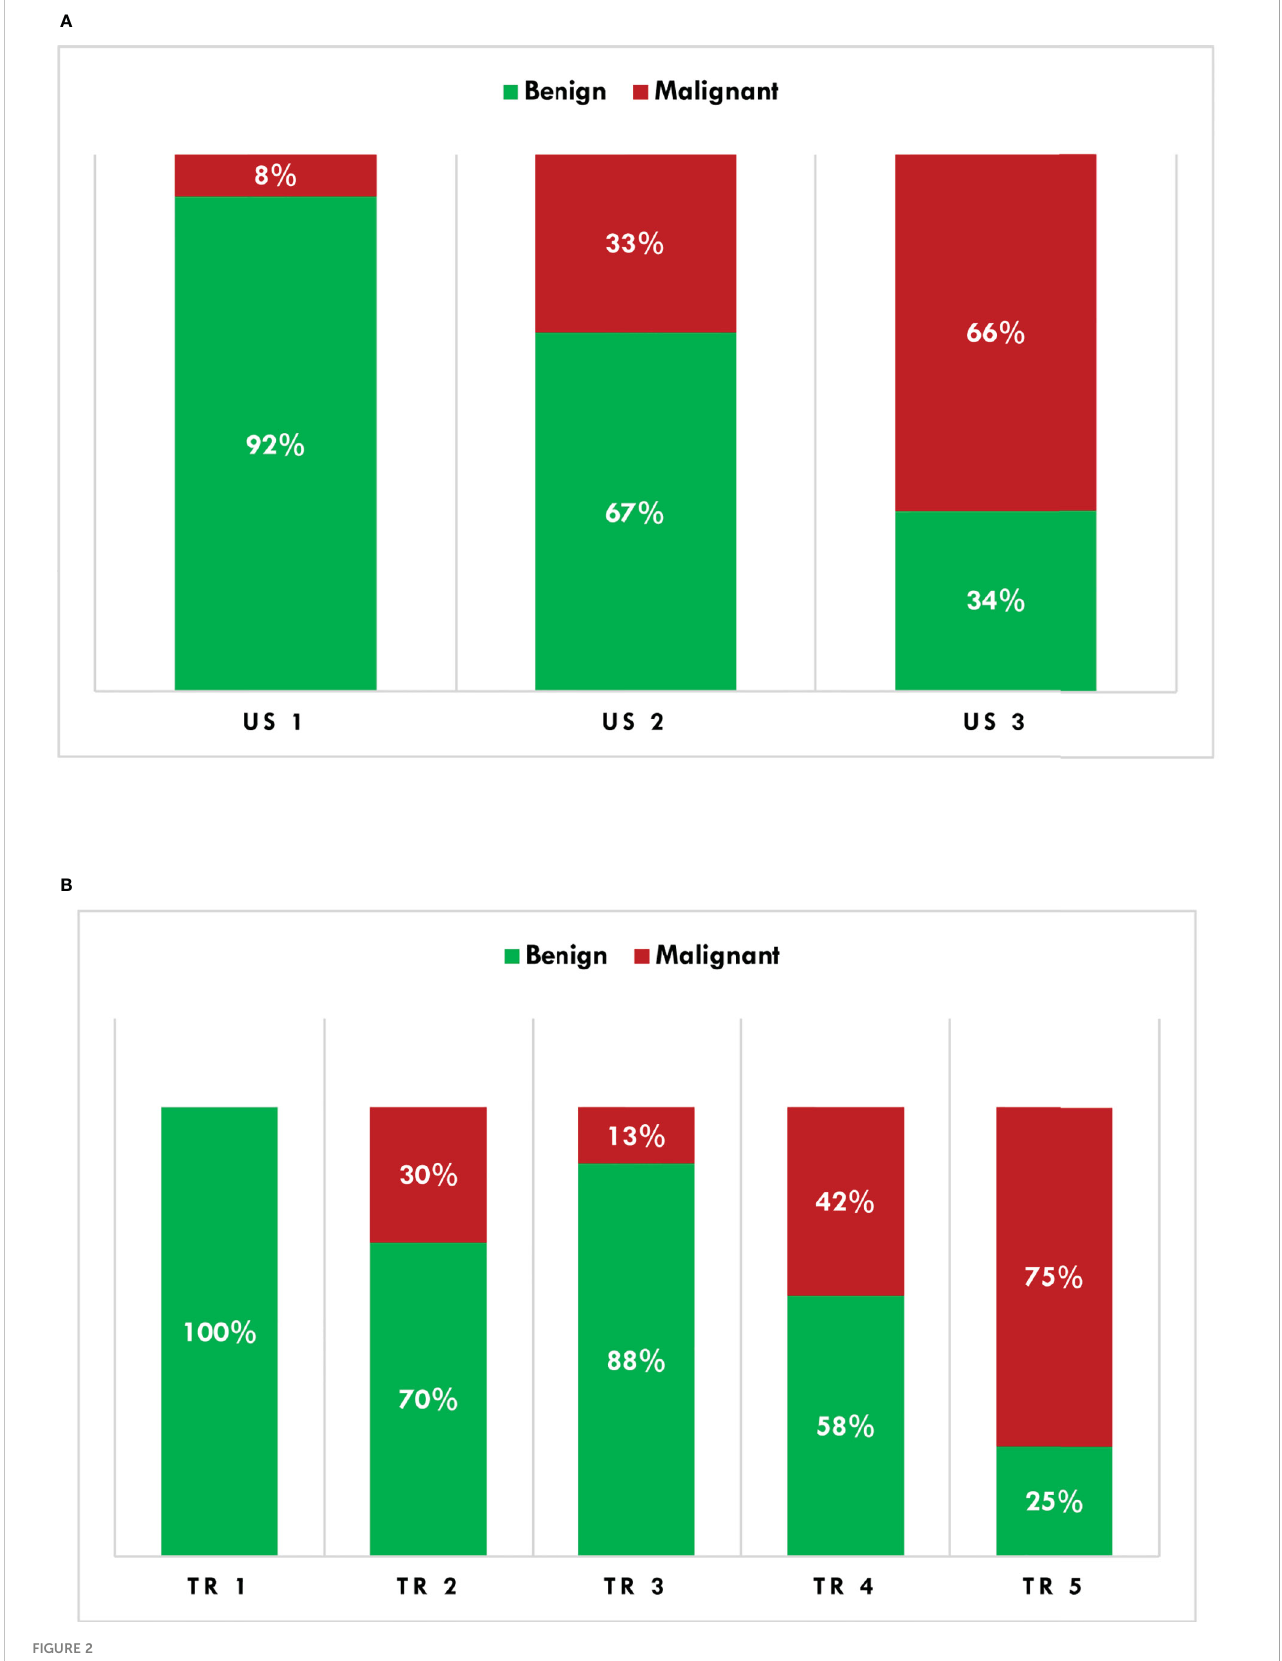
FIGURE 2 Histological characterization (binomial) of thyroid nodules according to the AACE/ACE/AME (A) and ACR TI-RADS (B) algorithms. AACE/ACE/AME, American Association of Clinical Endocrinology/American College of Endocrinology/Associazione Medici Endocrinologi; ACR TI-RADS, American College of Radiology Thyroid Imaging Reporting and Data